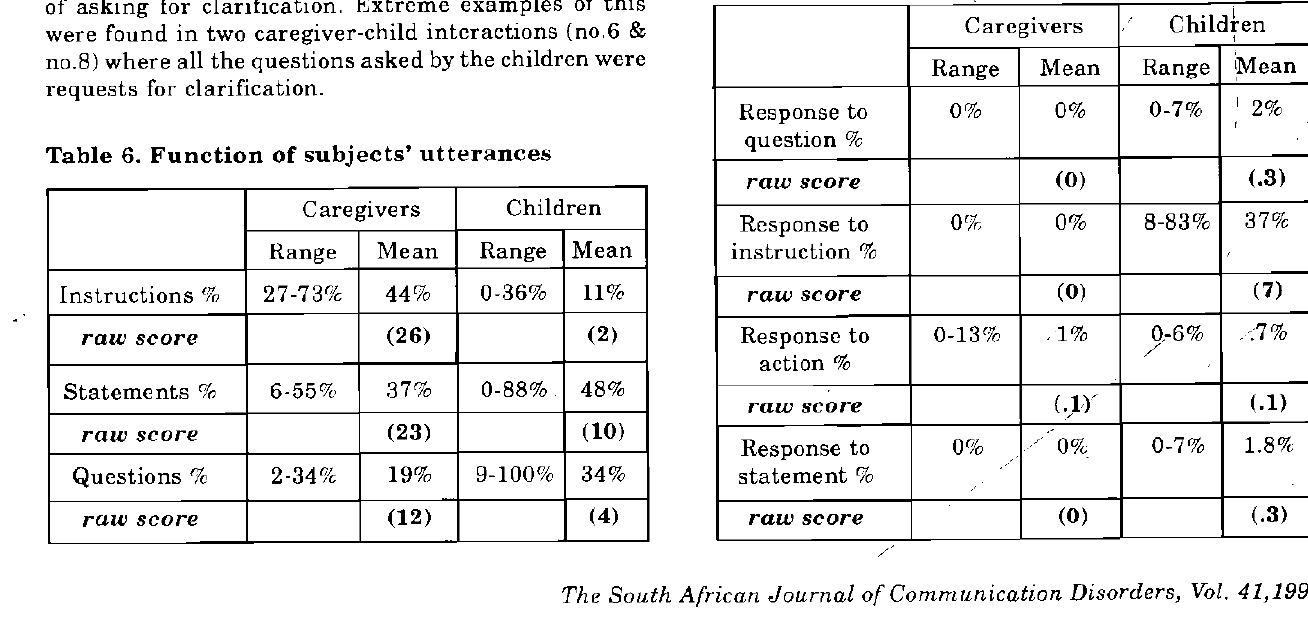
Table 7. Non-verbal Responses